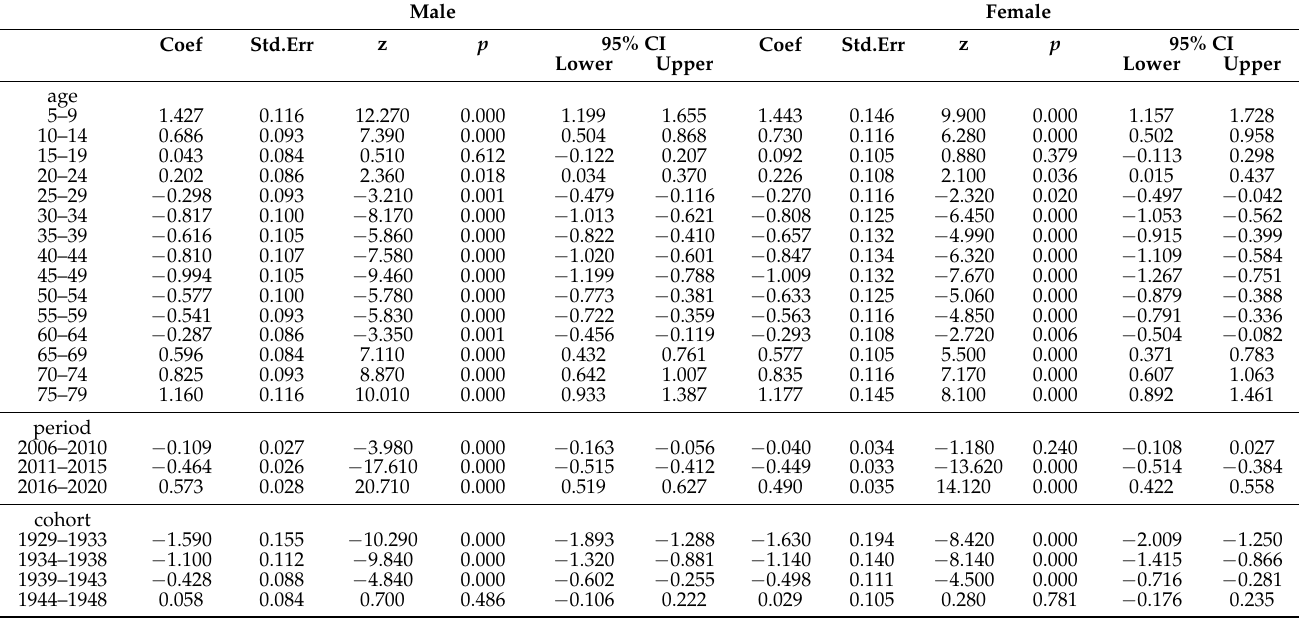
Table A3. Age–period–cohort analysis of injury and poisoning mortality rates for men and women in urban China,